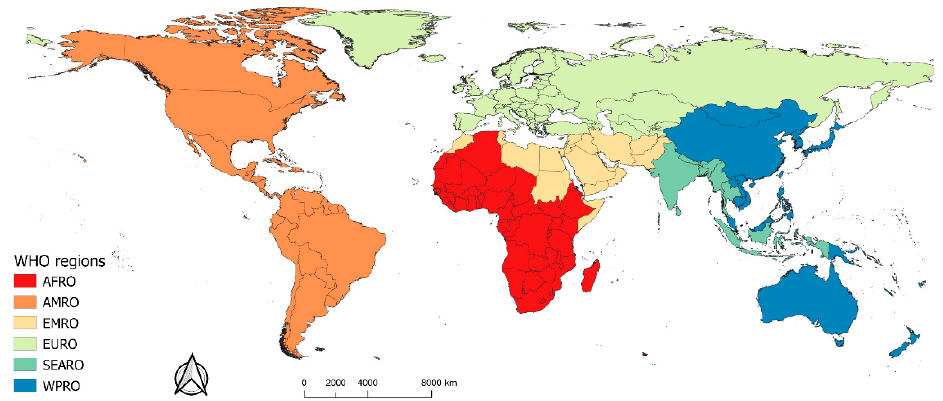
Figure 4. Global regions classification map.